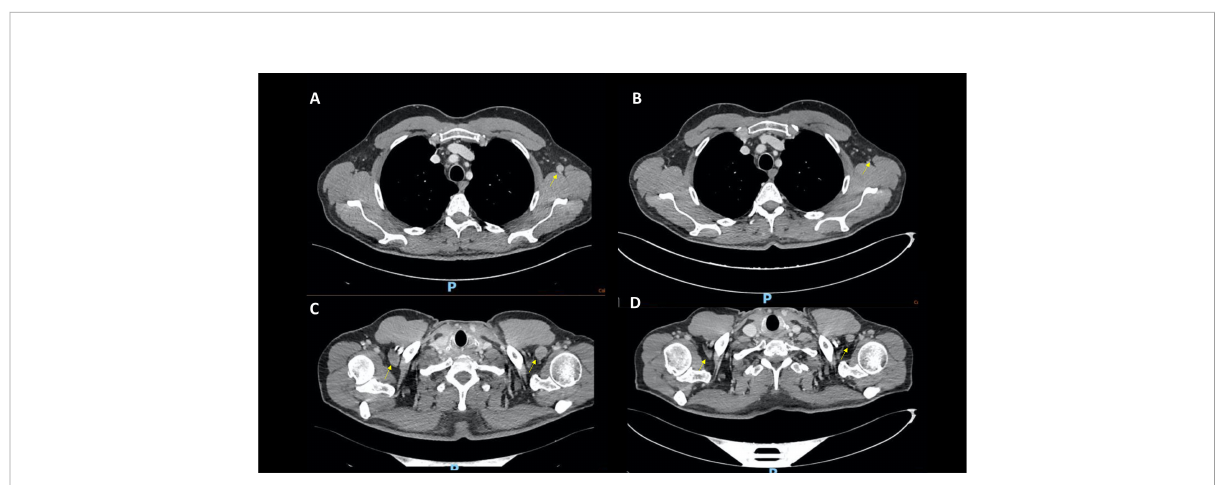
FIGURE 2 Case 2, CT scans showing signi fi cant shrinking in the axillary lymph nodes from December 2021 (A, C) to April 2022 (B, D) .